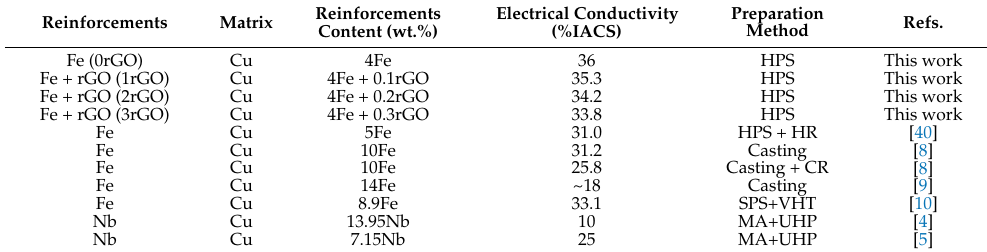
Table 1. Comparison of electrical conductivity of the as-prepared bulk composites and reported CMCs.